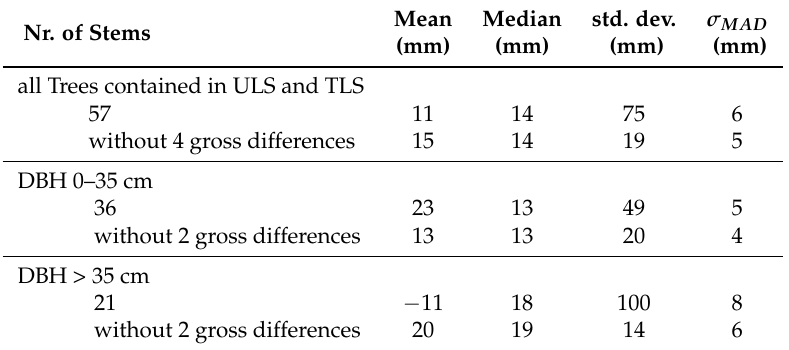
Table 1. DBH model comparison between ULS and TLS. 57 trees are contained in both TLS and ULS. Mean Median std. dev. σ MAD Nr. of Stems (mm) (mm) (mm) (mm) all Trees contained in ULS and TLS 57 11 14 75 6 without 4 gross differences 15 14 19 5 DBH 0–35 cm 36 23 13 49 5 without 2 gross differences 13 13 20 4 DBH > 35 cm 21 − 11 18 100 8 without 2 gross differences 20 19 14